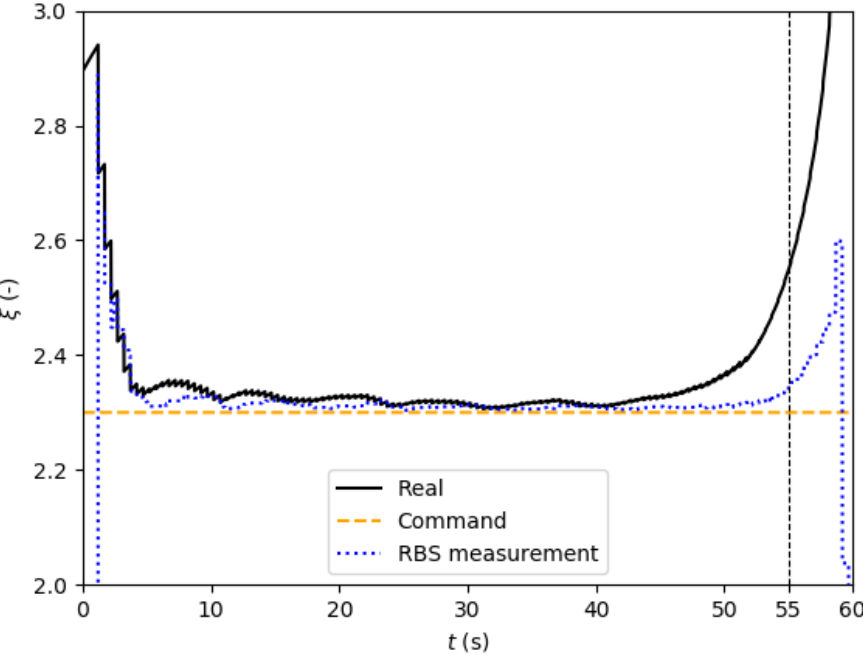
Figure 18. Mixture ratio profile, feedback with complete regulation law, case 1.